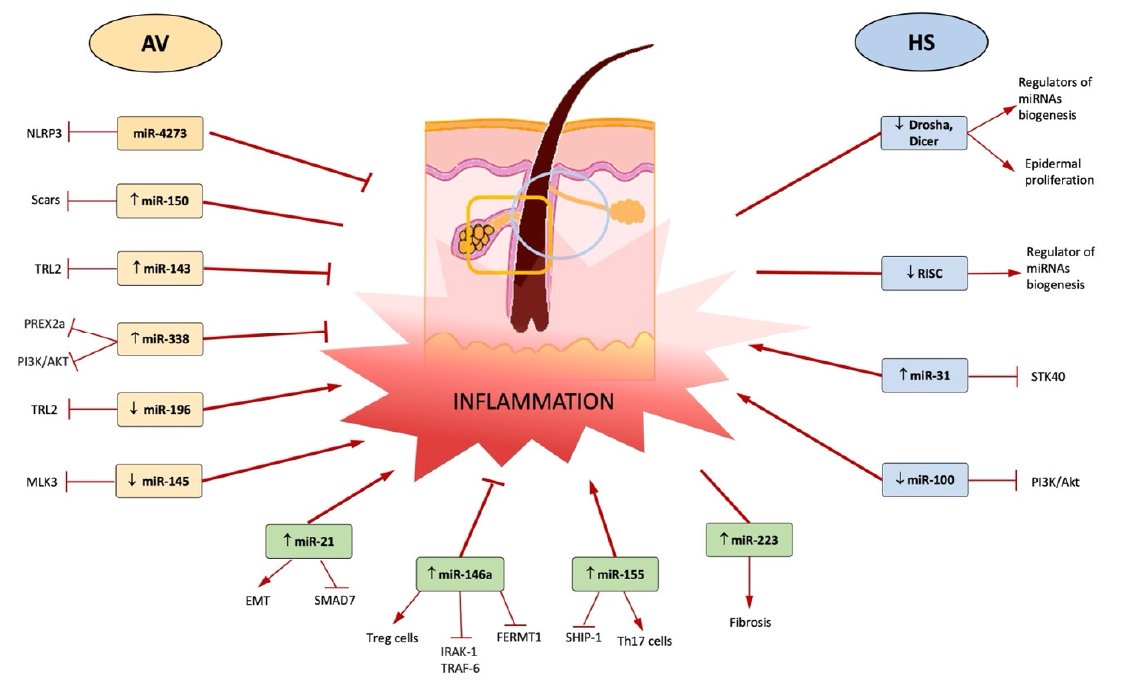
Figure 3. The center of the figure represents the follicular unit, which is the zone affected in both AV and HS. In AV inflammation regards the pilosebaceous unit (yellow rectangle), whereas in HS it regards the terminal hair follicles (blue circle). The miRNAs up- or downregulated in AV are shown on the left, and the miRNAs up- or downregulated in HS are shown on the right. The lower part of the figure shows the miRNAs up- or downregulated in both AV and HS. For each miRNA are reported the target and the final effect on inflammation (red arrows or line) during AV or HS.